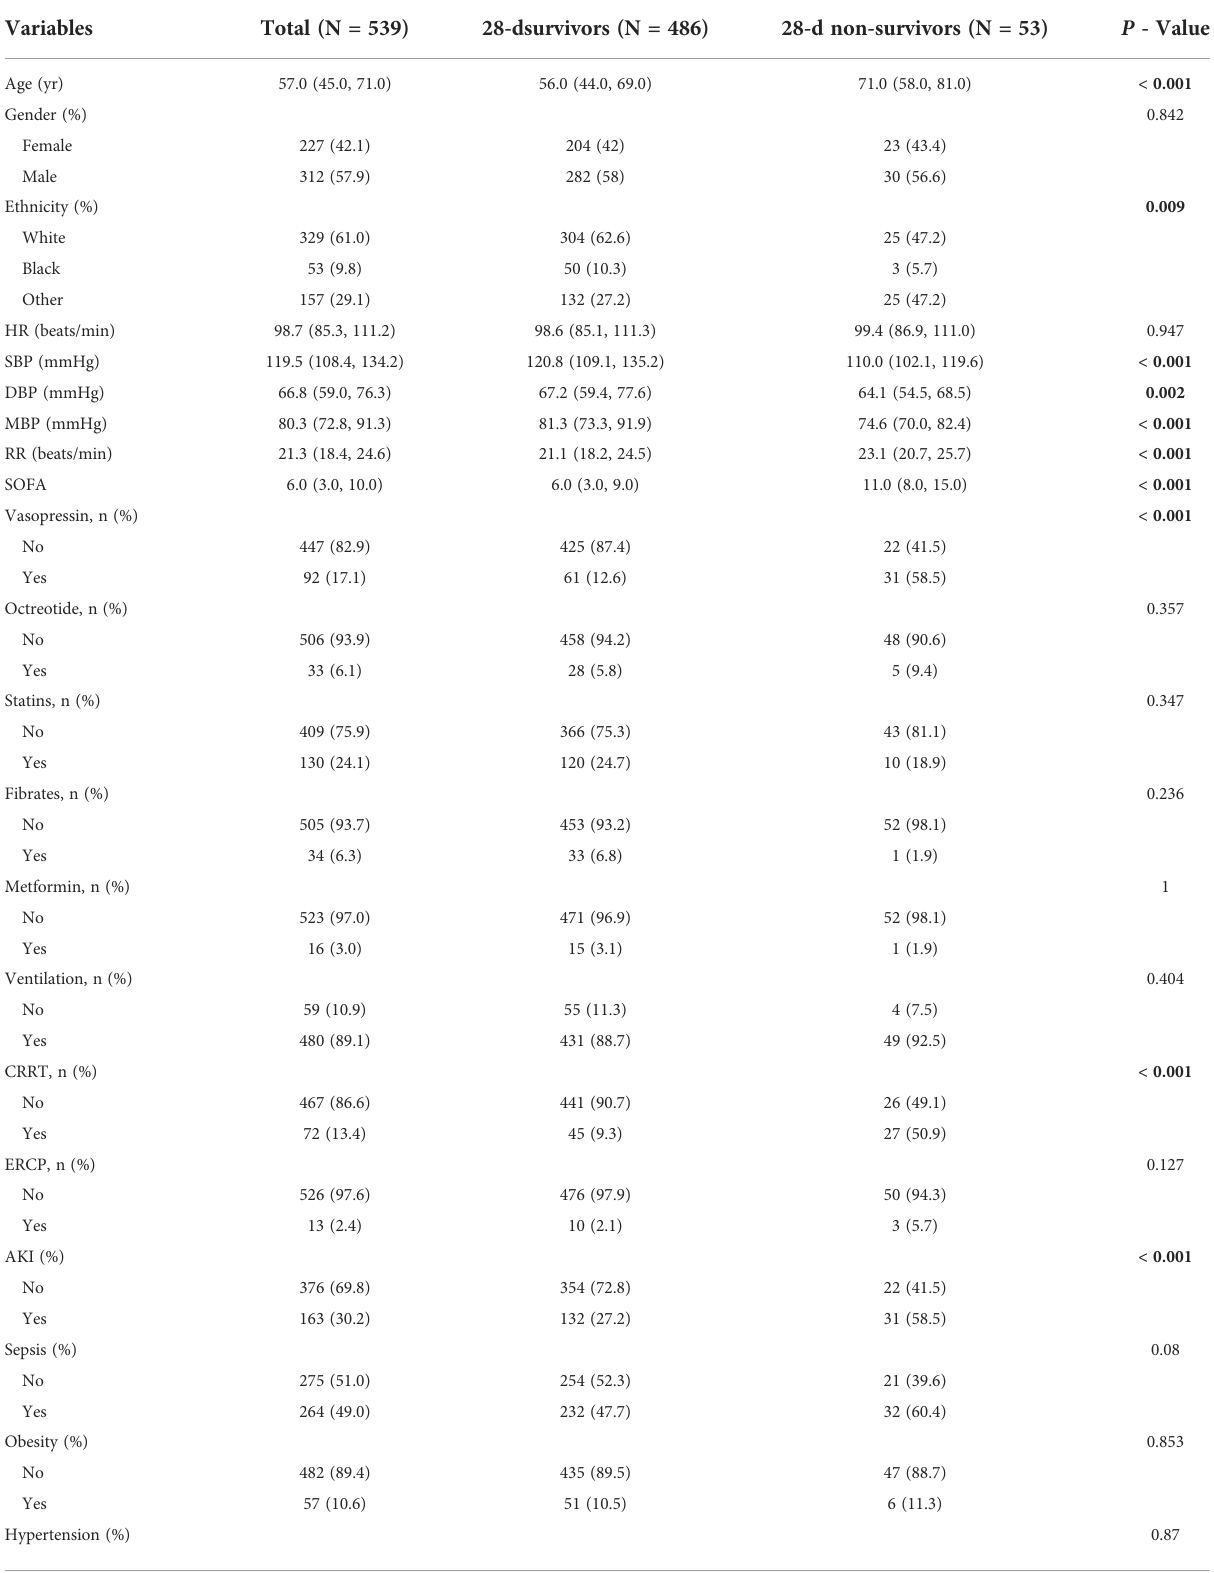
TABLE 1 Baseline characteristics between survivors and